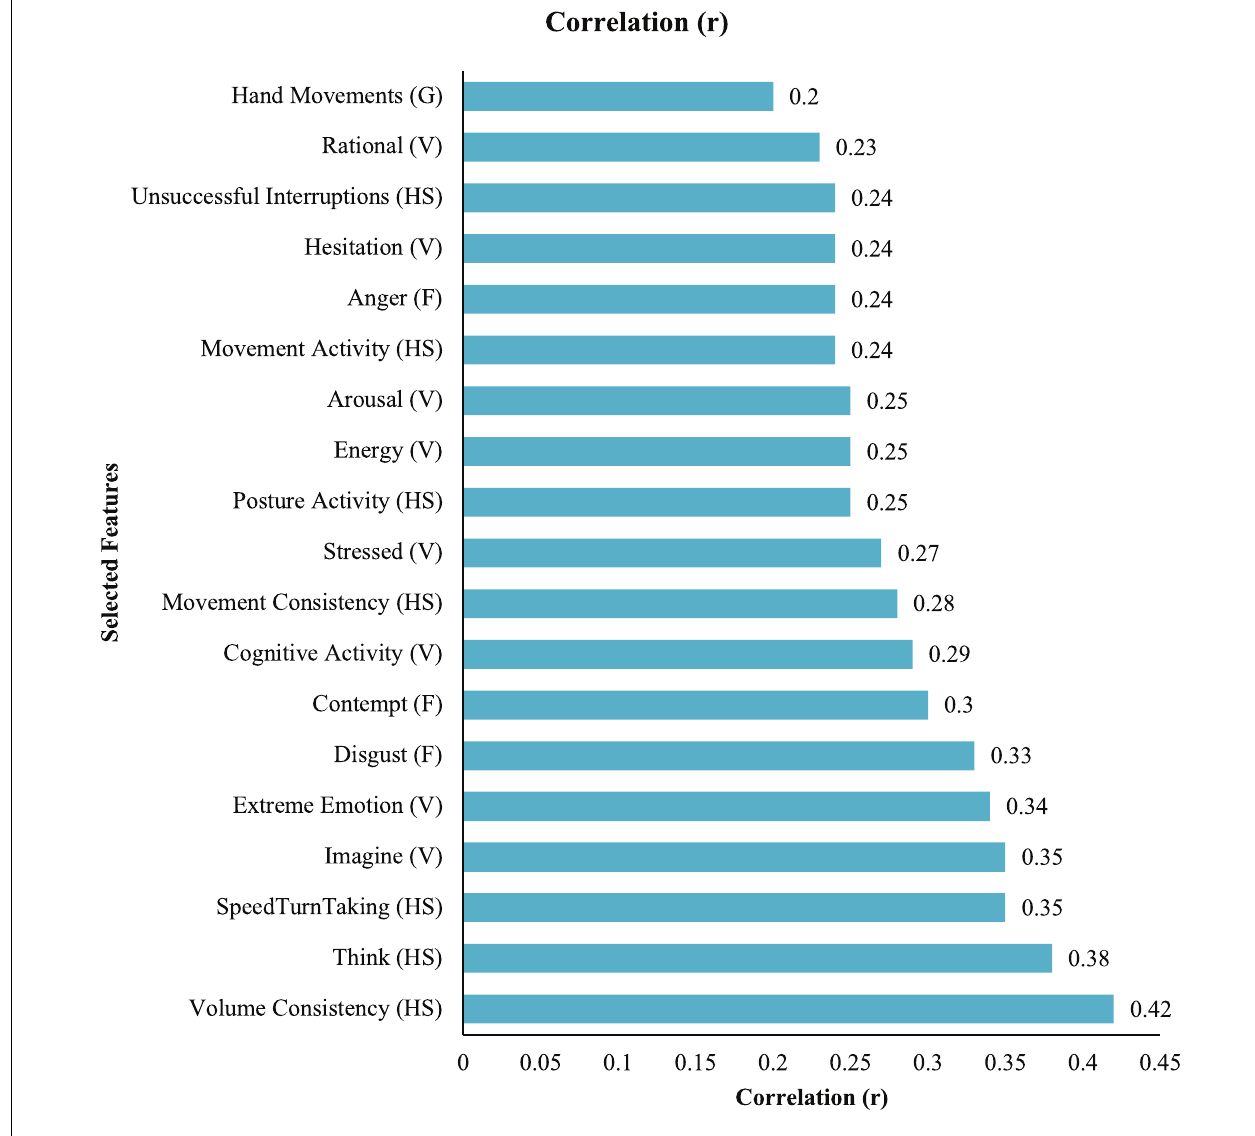
FIGURE 2 | Features selected for inclusion in machine learning classification. HS, honest signals; F, facial expression; V, vocal behaviour; G,